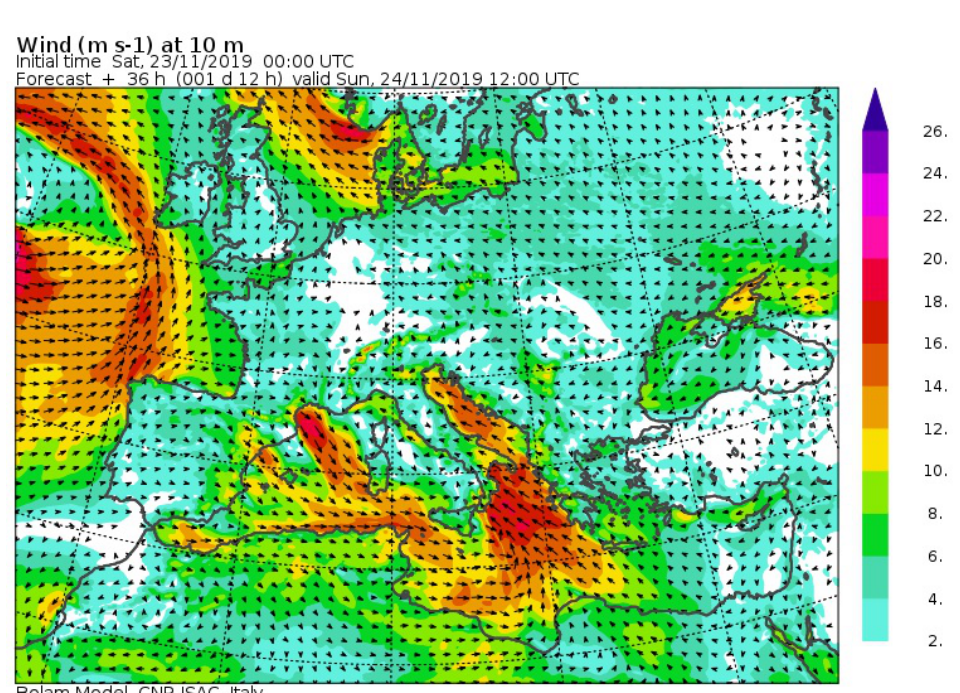
Figure A13. Map of the wind at 10 m height over the Mediterranean basin, as forecast for 24 November 2019 at 12 p.m. by the BOLAM model. The arrows indicate the wind direction and the wind speed is shown in the colour scale.